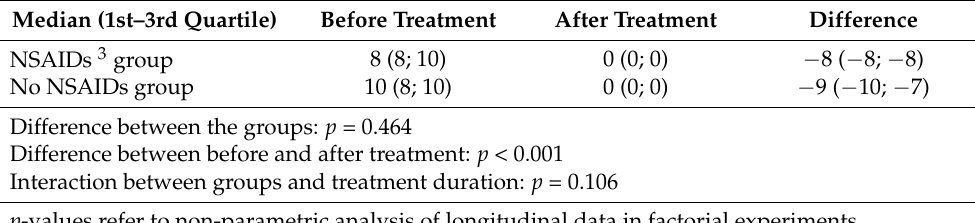
Table 3. NRS 1 pain intensity before and after treatment of BME 2 of the knee.